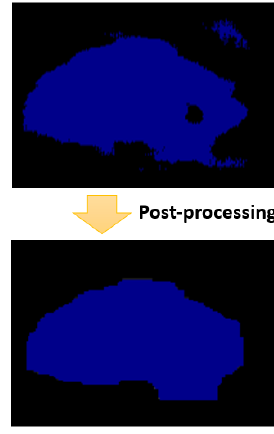
Figure 11. Segmentation map of the spinal cord before and after the post-processing